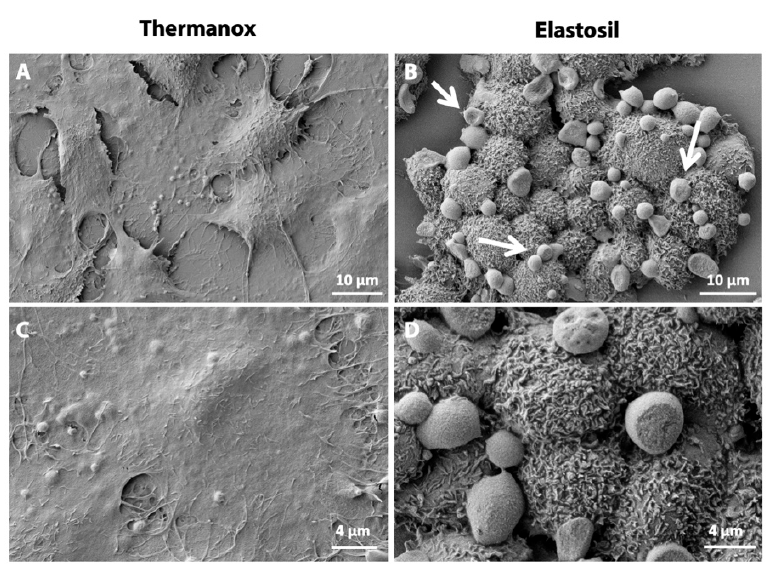
Figure 3. Scanning electron microscopy images of A549 cells cultured on Thermanox™ Coverslips ( A , C ) and Elastosil ® Film ( B , D ) after 72 h of culture. Arrows indicate surfactant on the apical surface of